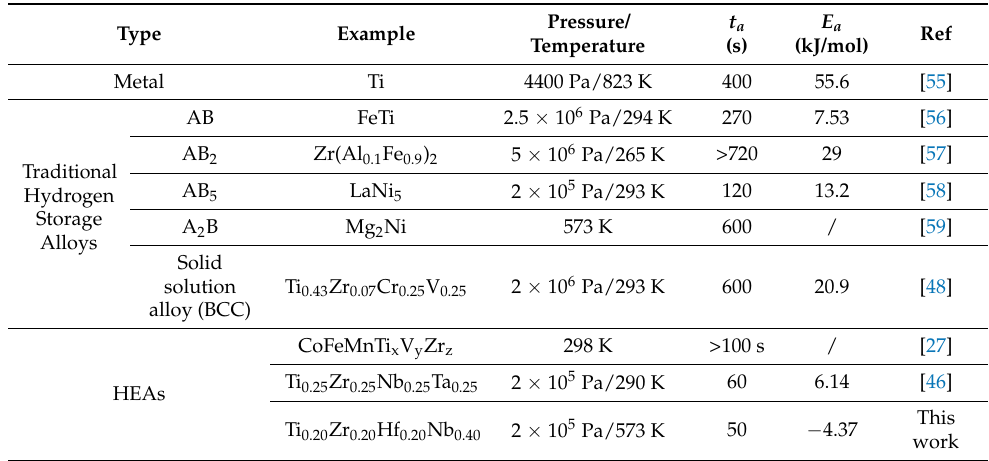
Table 6. Comparison of dynamic performance between traditional hydrogen storage alloys and some